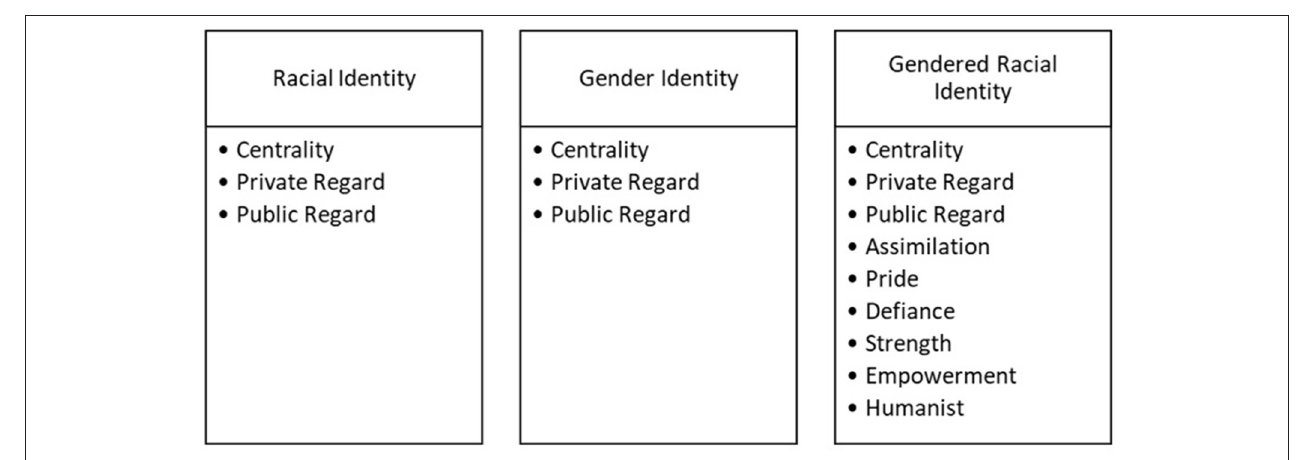
FIGURE 2 | Identity codes and